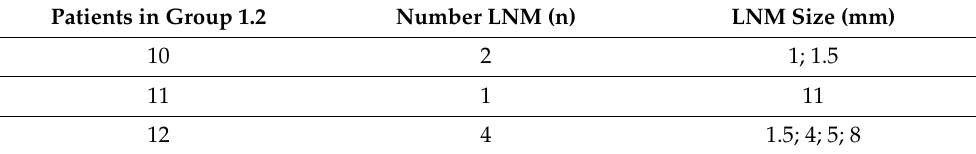
Table 4. Cont. Patients in Group 1.2